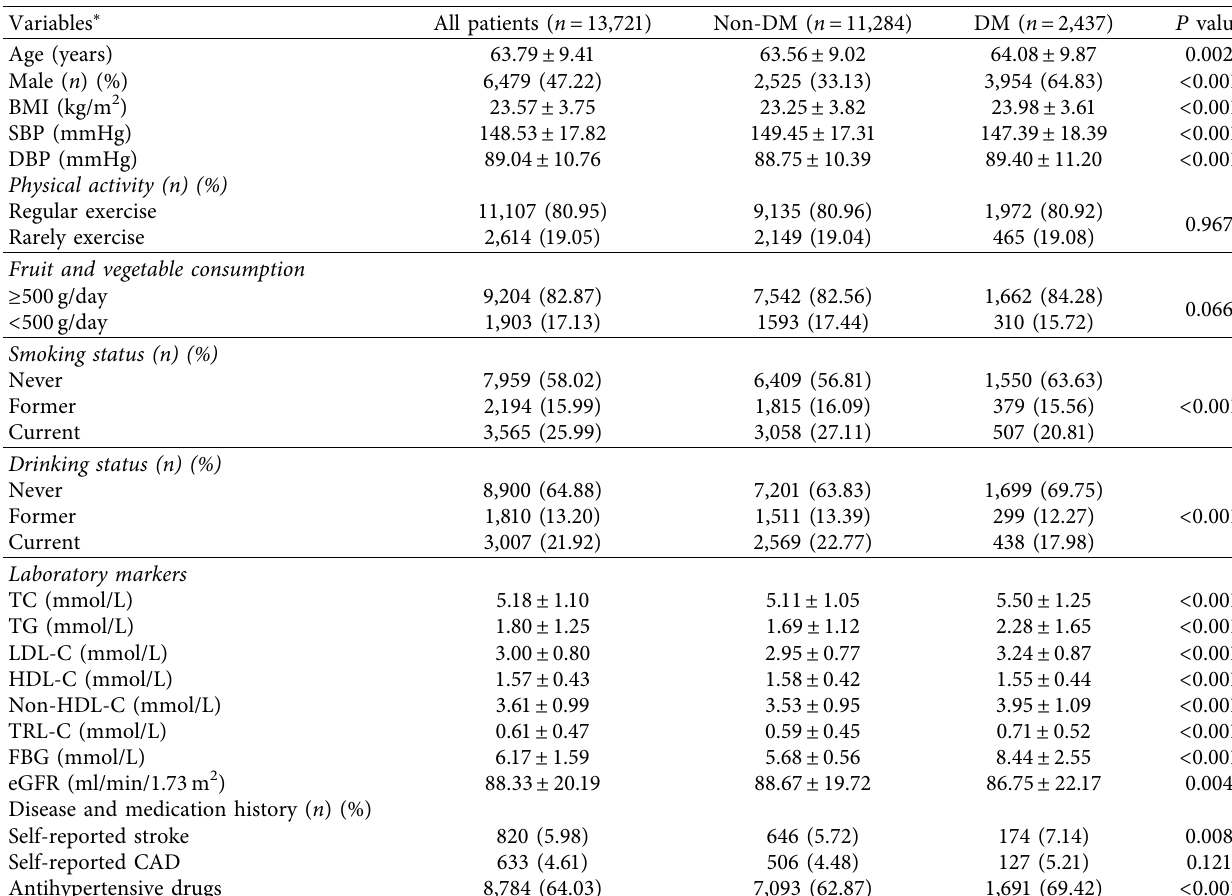
Figure 1: Flow chart of study participants. Table 1: Characteristics of study